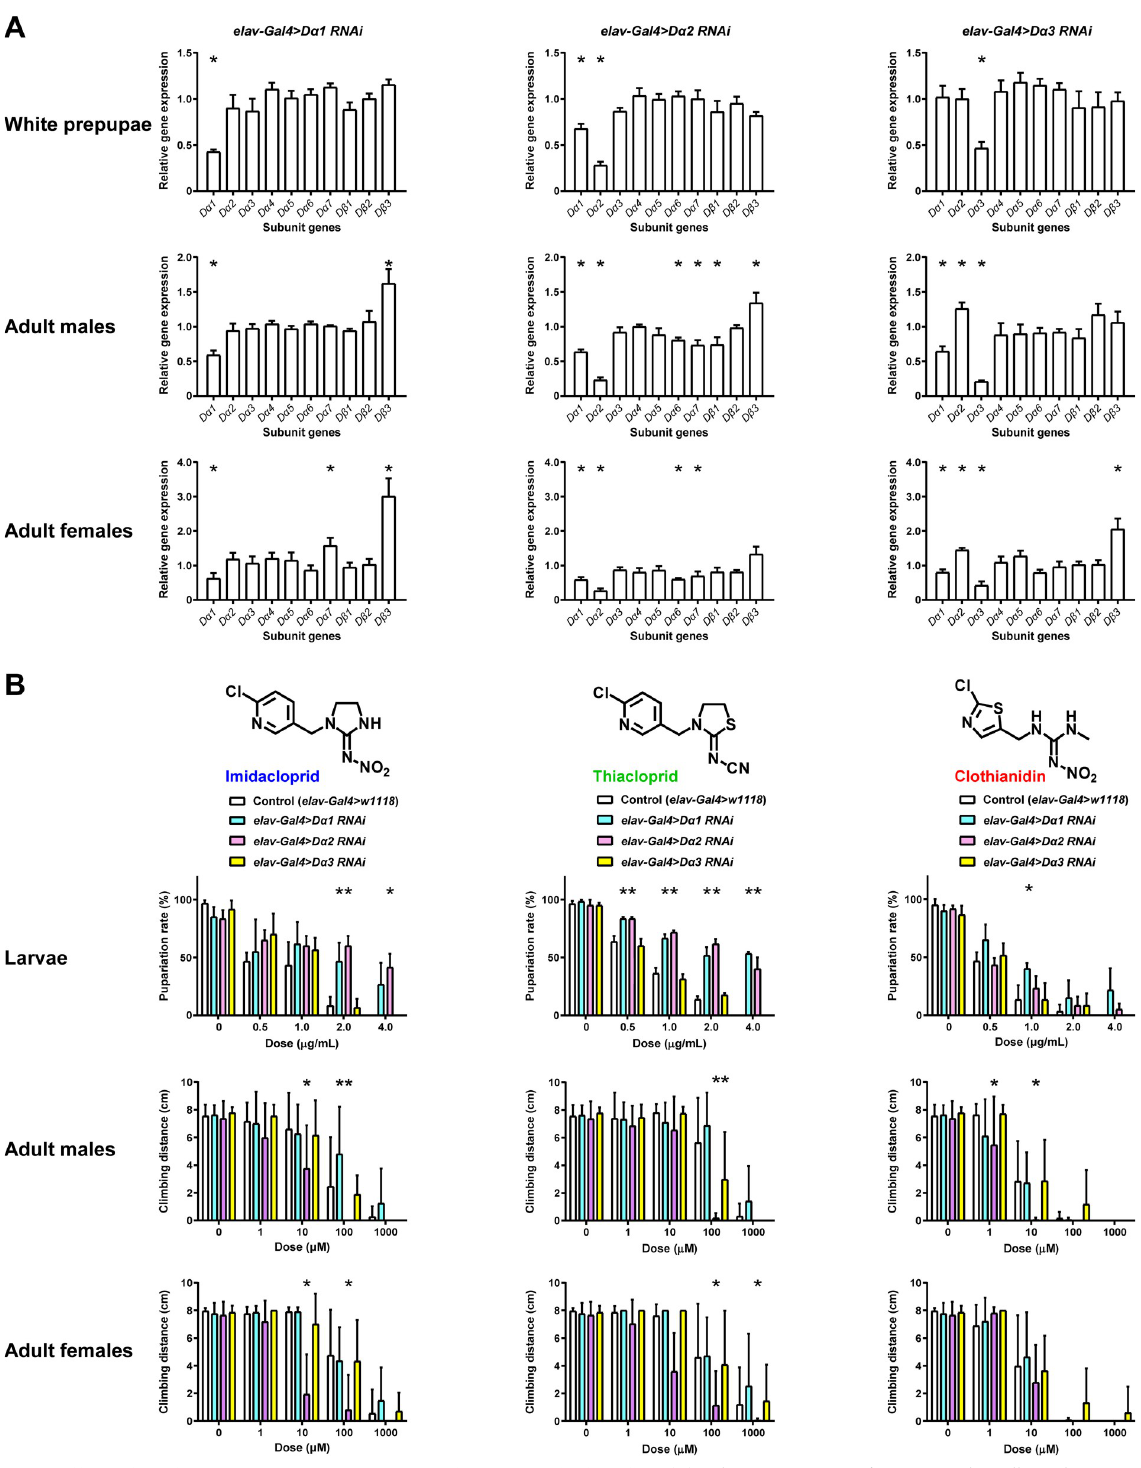
Fig 5. Effects of α subunit gene RNAi on neonicotinoid toxicity in the fruit flies. ( A ) Relative expression of genes encoding all nAChR subunits by pan-neuronal knockdown of D α 1 , D α 2 , and D α 3 in white prepupae and adults of D . melanogaster . elav-Gal4 > UAS-dicer2 was used to induce RNAi in all neurons. Each bar indicates the mean ± standard deviation (n = 3). Asterisk indicates that the gene expression level changes as compared with the control ( elav-Gal4 > w 1118 ) ( t -test, P < 0.05). ( B ) Toxicity of neonicotinoids by pan-neuronal knockdown of D α 1 , D α 2 , and D α 3 in larvae and adults of D . melanogaster . Each bar represents the mean ± standard deviation (pupariation rate assay, n = 3;